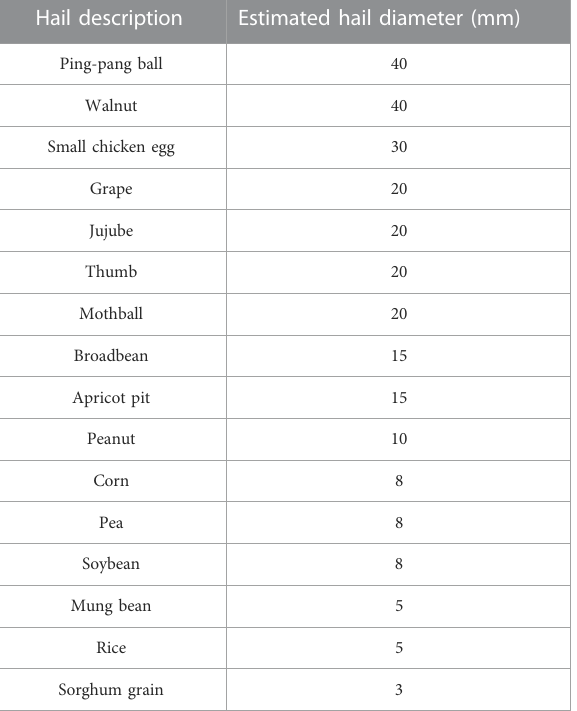
TABLE 1Estimated hail diameter, as interpreted from disaster information. Hail